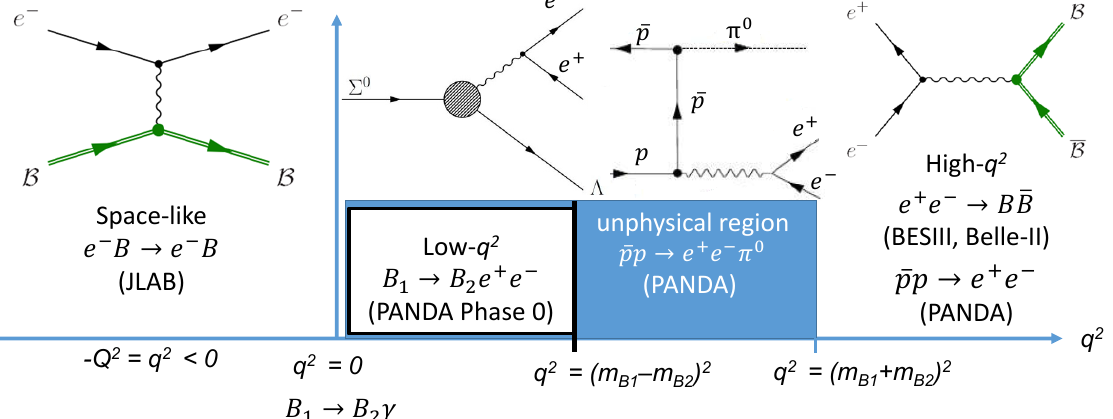
Figure 4. Processes for extracting EMFF in the space-like (left) and time-like (right) region. The low- q 2 (4 m 2 part of the time-like region is studied by Dalitz decays, the unphysical region (4 m 2 high- q 2 region ( q 2 > ( m B 1 + m B 2 ) 2 ) by B ¯ B ↔ e + e − . Note that the unphysical region is only accessible for